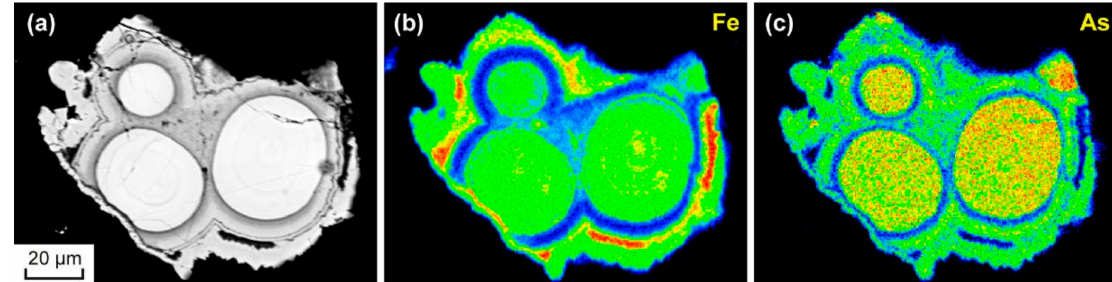
Figure 13. Aggregates of kidney-shaped pitticite covered with Fe hydroxides in loose sediments of the watercourses draining the Au – Ag zones of the Dukat deposit. Images are taken in: ( a ) backscattered electrons; ( b , c )